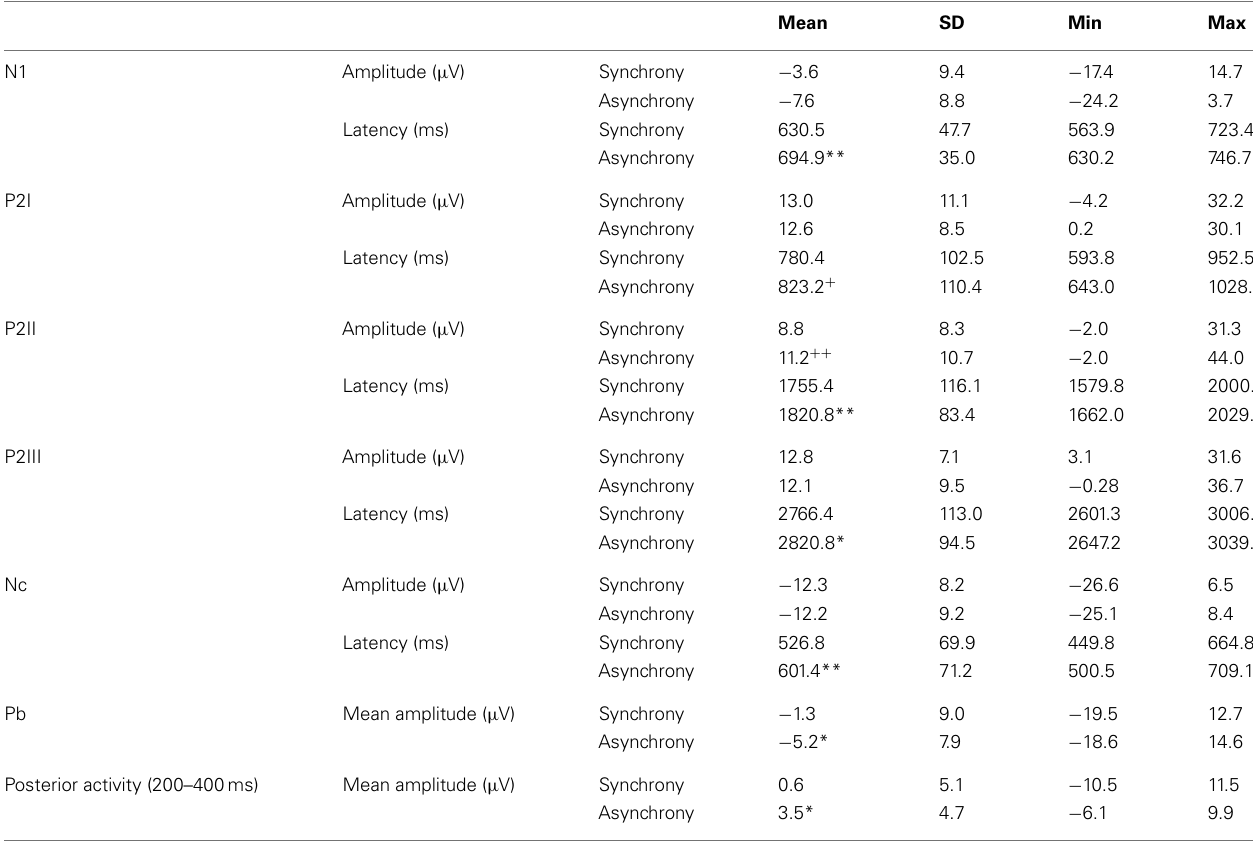
Table 1 | Summary of descriptives of ERP components analyzed in synchronous and asynchronous trials in the specific regions of